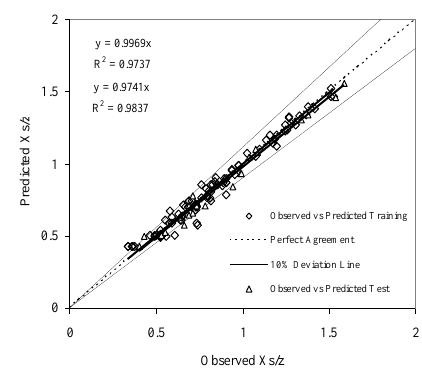
Figure 20. Comparison between observed and predicted s/z of ANN in training and testing stages.